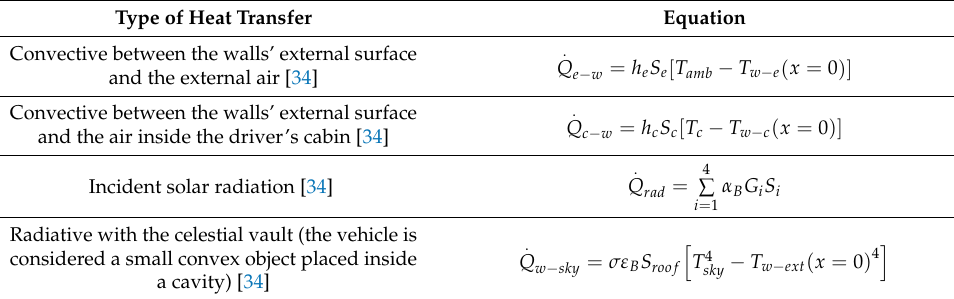
Table A5. Heat transfer in the refrigerated